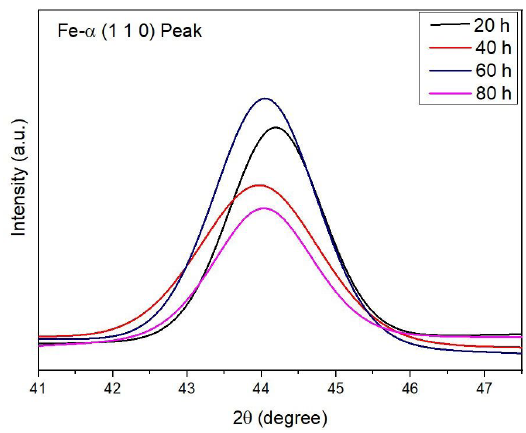
Nb phases appeared after 20 hours of MA and remained SS in crystal form until 60 hours. At 80 hours only the most intense Fe-α peak with low crystallinity is present.